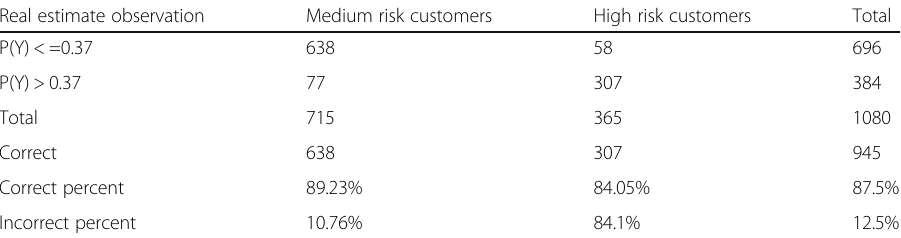
Table 5 Performance of the model. To evaluate the performance of the model, we use its predictive power for data outside the model. 54,000 records that were not used in training were entered into the model and their probability was calculated and compared with the values of the table. The degree of sensitivity and diagnosis of the model were 0.84.05% and 89.23%, respectively Real estimate observation P(Y) < =0.37 P(Y) >